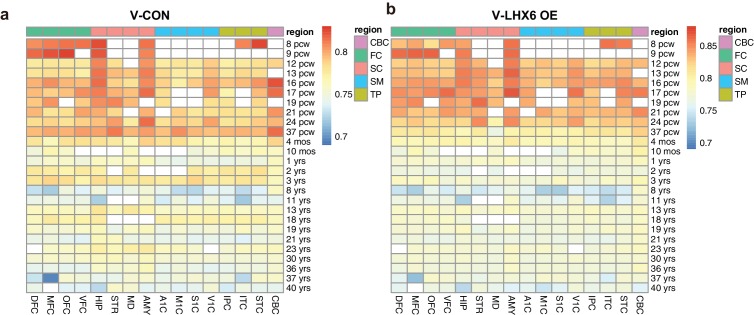
Comparison of hPSC-derived 50-day-old neurons with human fetal brain.(a–b) Gene expression of V-CON (a) and V-LHX6 OE (b) human-induced pluripotent stem cell (hiPSC) 50-day-old neurons, which most closely resemble human first trimester brain cortex. The heatmaps display the Spearman correlation of our samples with data from regions of the human brain taken from the Brainspan Atlas of the Developing Human Brain (http://www.brainspan.org). White-filled cells indicate missing data.